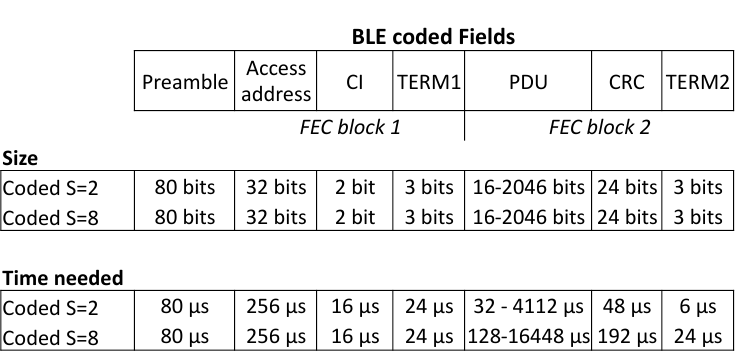
Figure 3. Coded packet